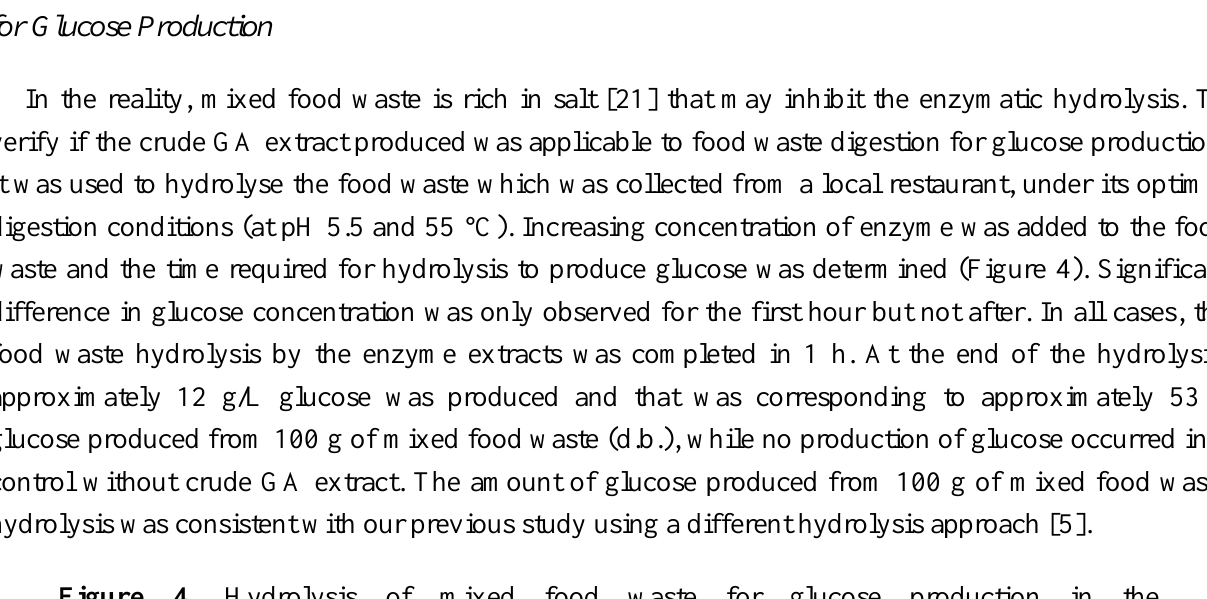
) and half-lives (t ) of the crude GA extract at 55, 60 d 1/2